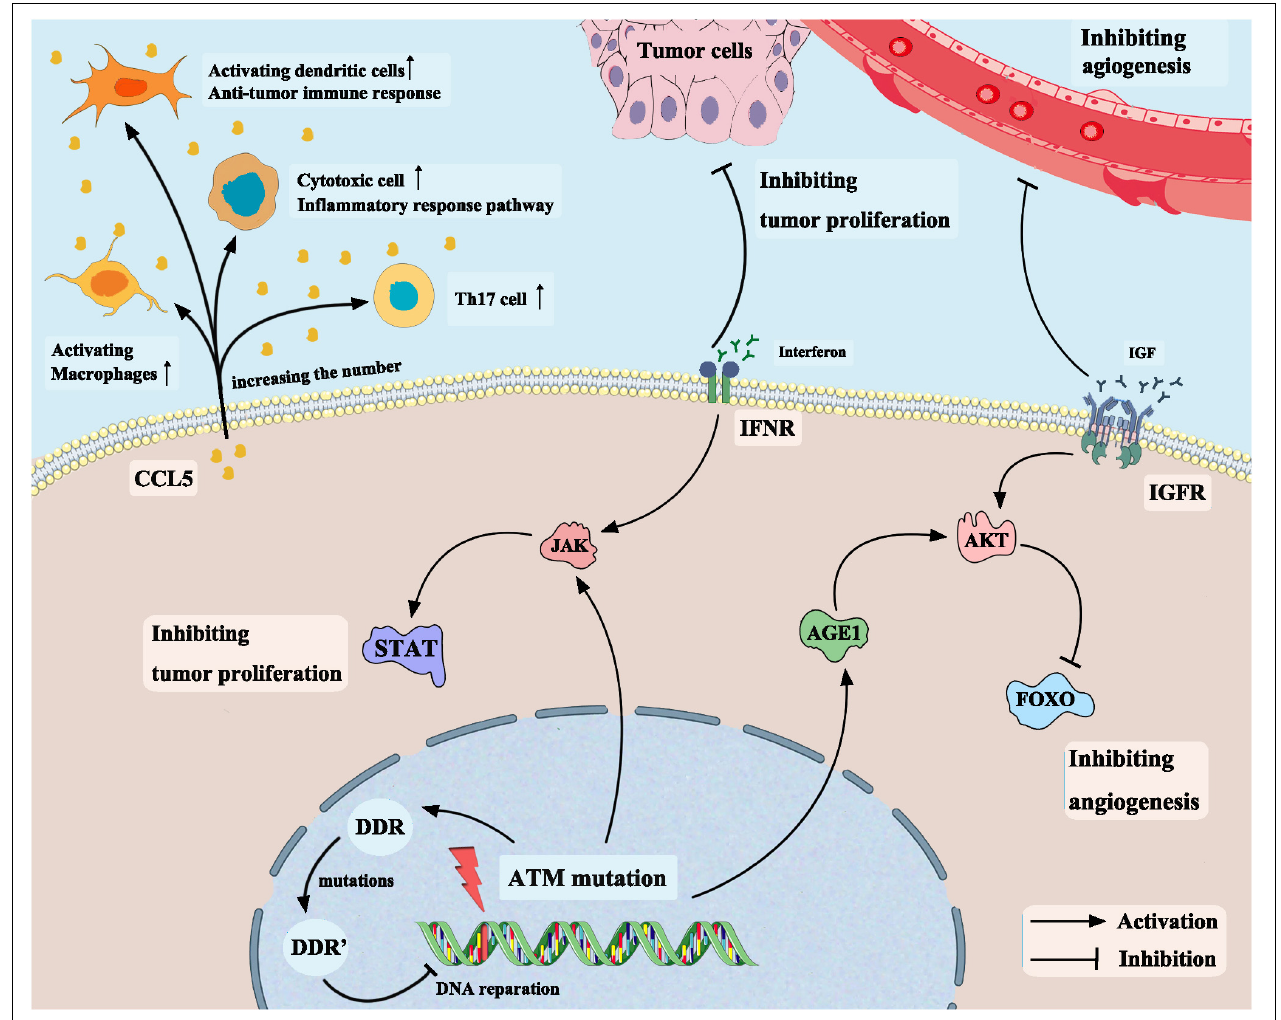
FIGURE 7 | Mechanism of ATM mutation enhancing the efficacy of immune checkpoint inhibitors in bladder cancer based on a hypothetical model.